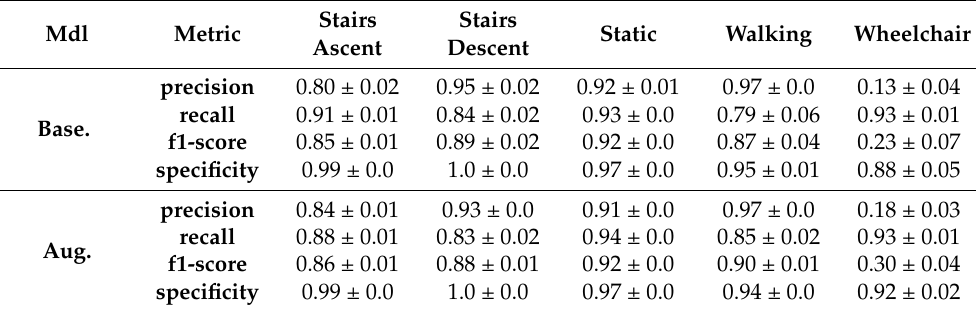
Table A6. Single class results of the baseline and augmented model for the real-life test set. Considered data: SHS